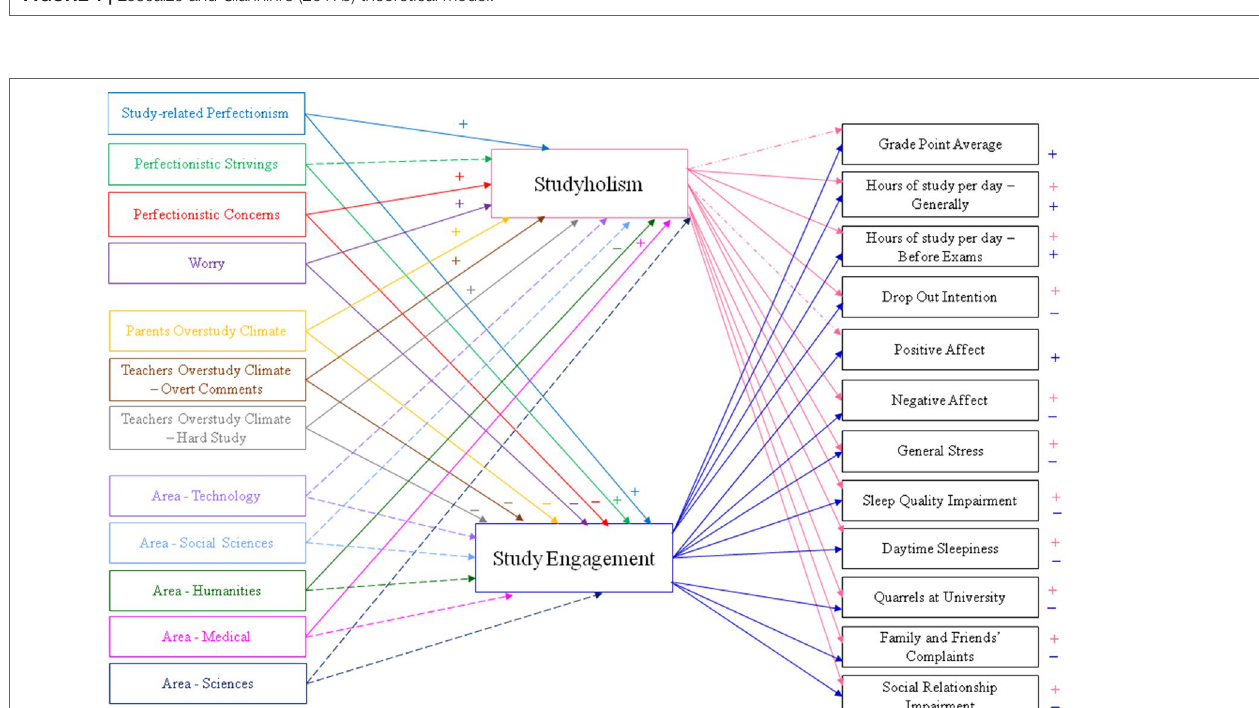
FIGURE 2 | Hypothesized model for Studyholism and Study Engagement antecedents and